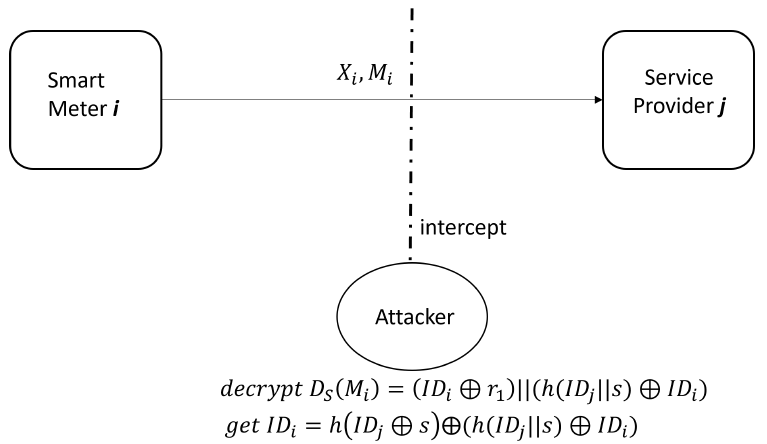
Figure 4. Attacker intercepts on SM i ’s